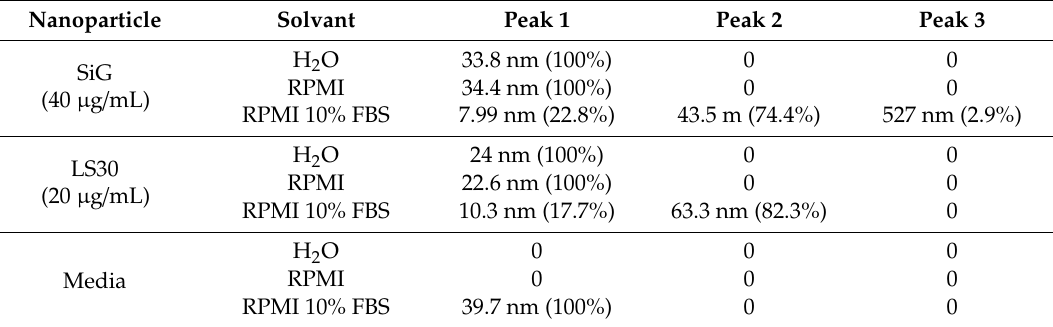
Table 1. Nano-size distribution of silica nanoparticles in water and culture media by DLS. LS30 for Ludox ® LS silica from Grace, SiG for Sicastar ® -greenF, RPMI for Roswell Park Memorial Institute 1640 medium, FBS for fetal bovine serum. The Z-average of particles and their proportion in the solution are